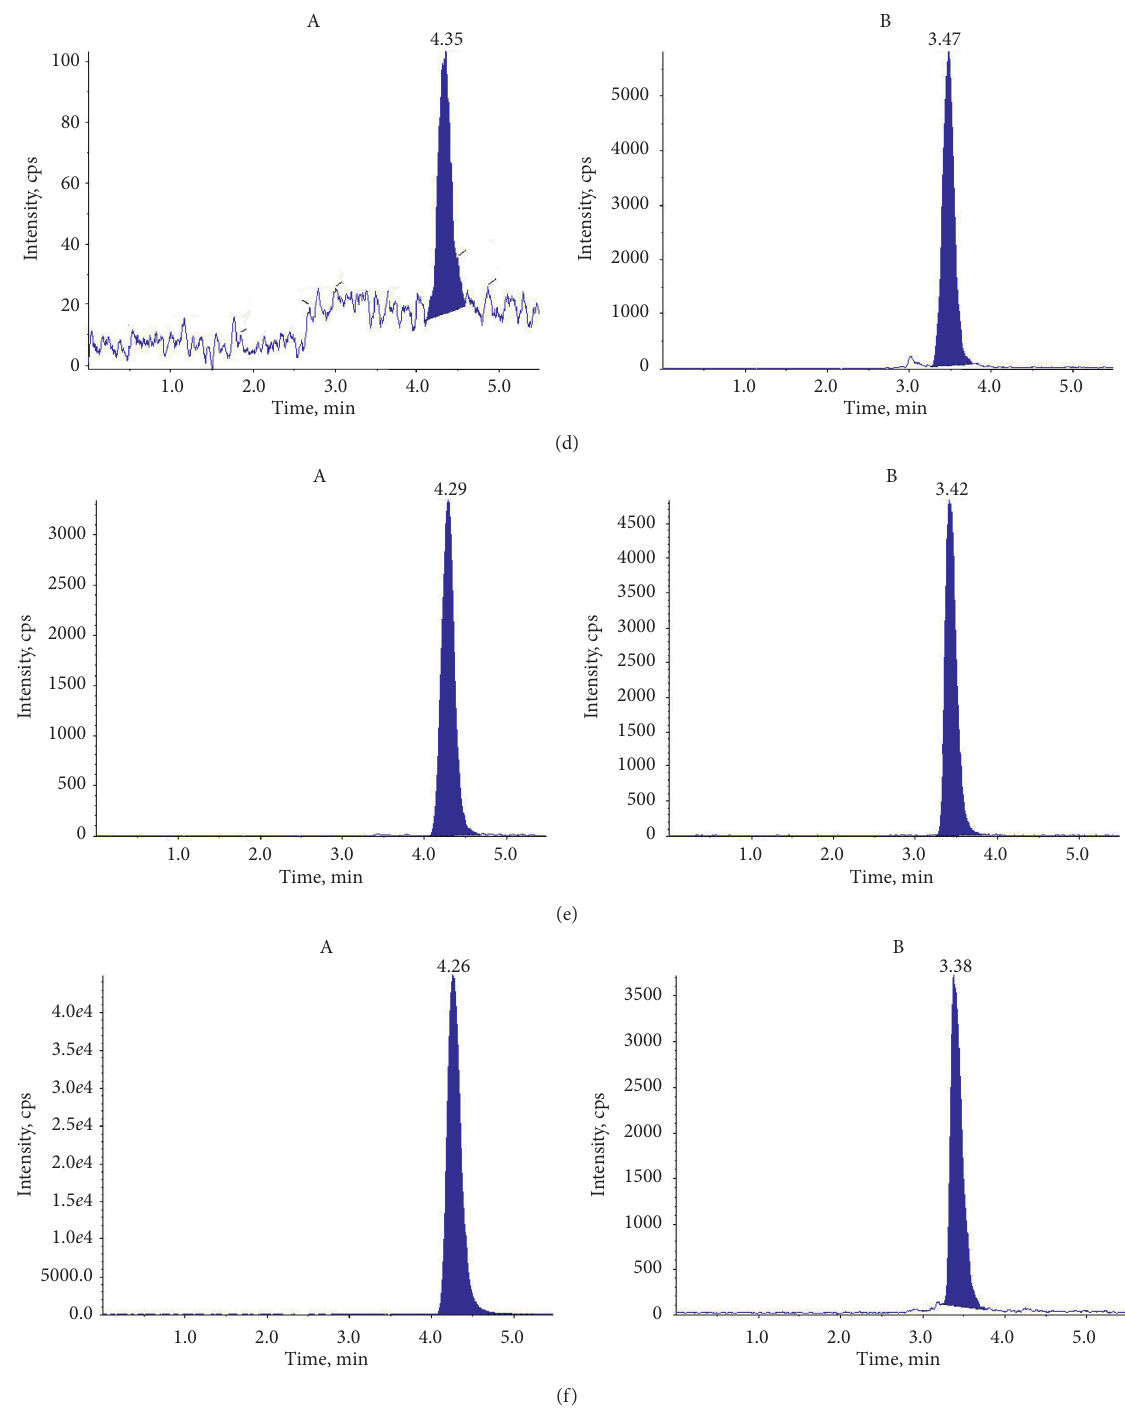
Figure 2: Typical chromatograms of Schisandrol B and IS in blank rat plasma (a) and liver homogenates (b); blank rat plasma (c) and liver homogenates (d) spiked with LLOQ and IS; and rat plasma (e) at 1h and liver homogenate samples at 0.5h (f) following the oral ad- ministration of 10mg/kg Schisandrol B. A corresponds to Schisandrol B, and B corresponds to